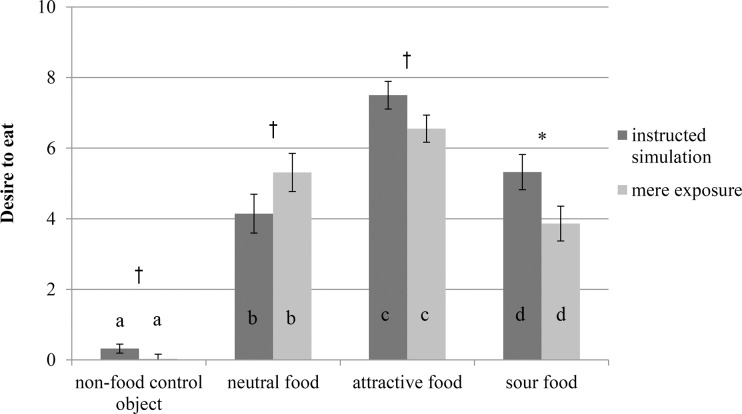
Desire to eat by object type and condition in Experiment 2.Different letters indicate significant differences between objects within a condition, p < .05. Asterisks indicate significant differences between conditions for an object, p < .05, and daggers indicate that p < .10. Error bars represent standard errors from the mean.